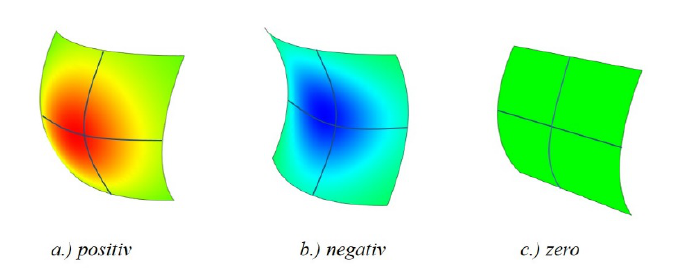
Fig. 5 Types of Gaussian Curvatures a.) positive, b.) negative and c.)